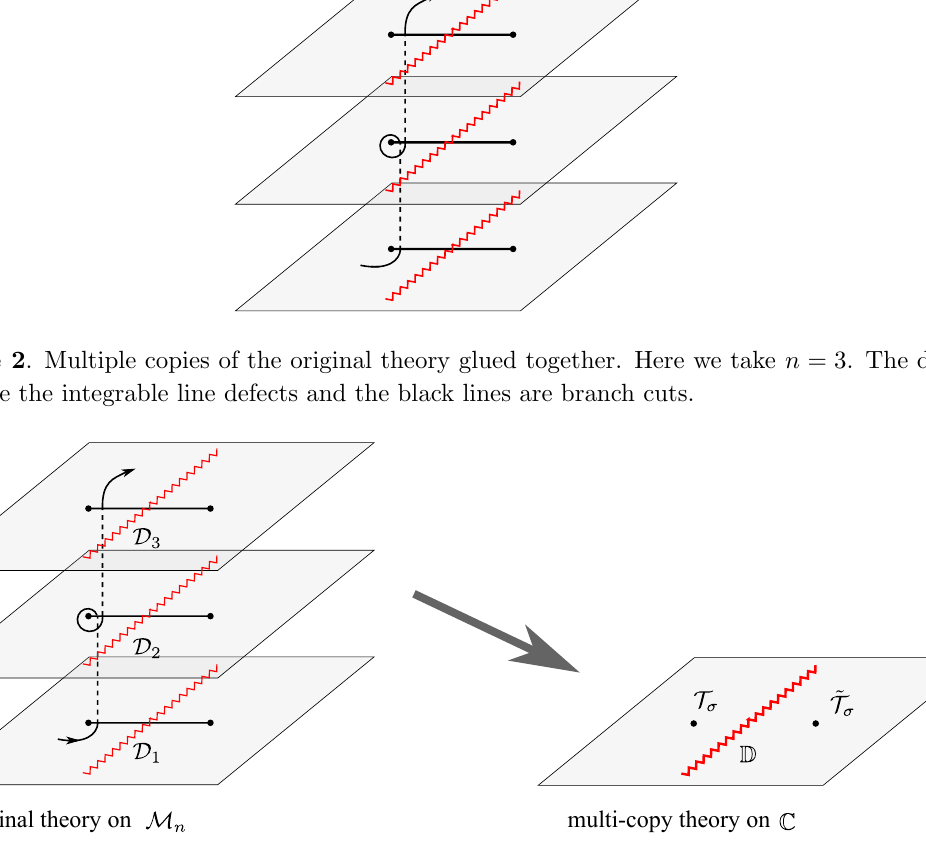
Figure 3 . From original theory on the Riemann surface M n to the multi-copy theory on C . The boundary conditions for the (cid:12)elds of the multi-copy theory can be taken into account by introducing branch-point twist